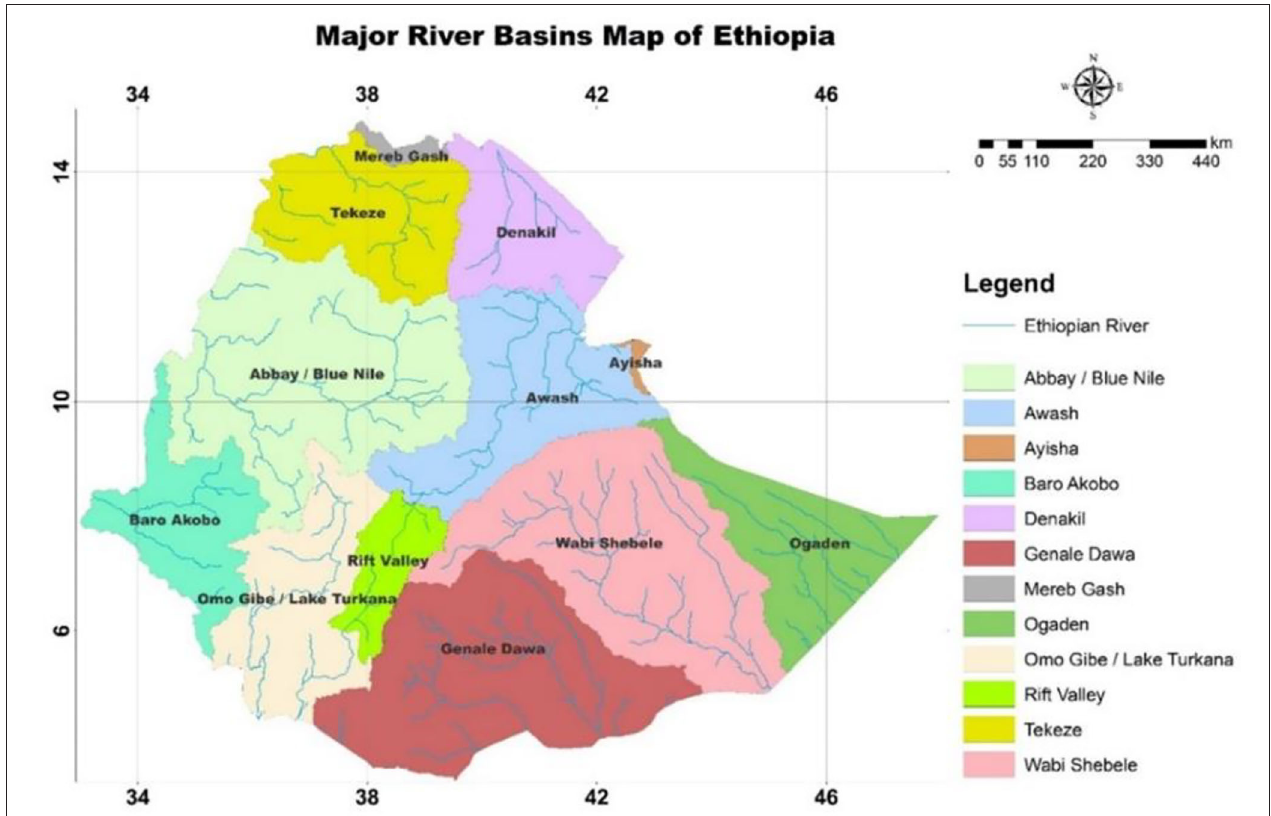
FIGURE 1 | Major river basins of Ethiopia. Source: Awulachew et al.